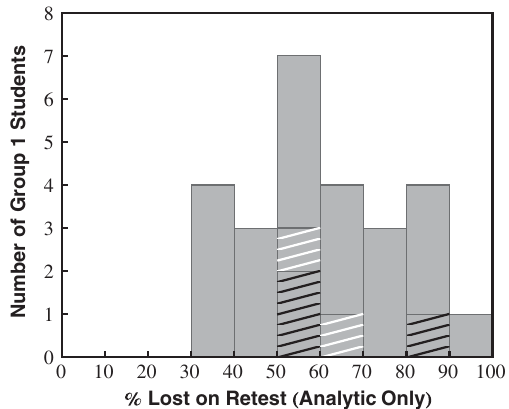
FIG. 7. Histogram showing the number of students in group 1 with a given loss fraction on the analytic problems of the retest. The hatched areas are a stacked histogram of the students who self-reported full (white) or less than full (black) effort on this portion of the retest.